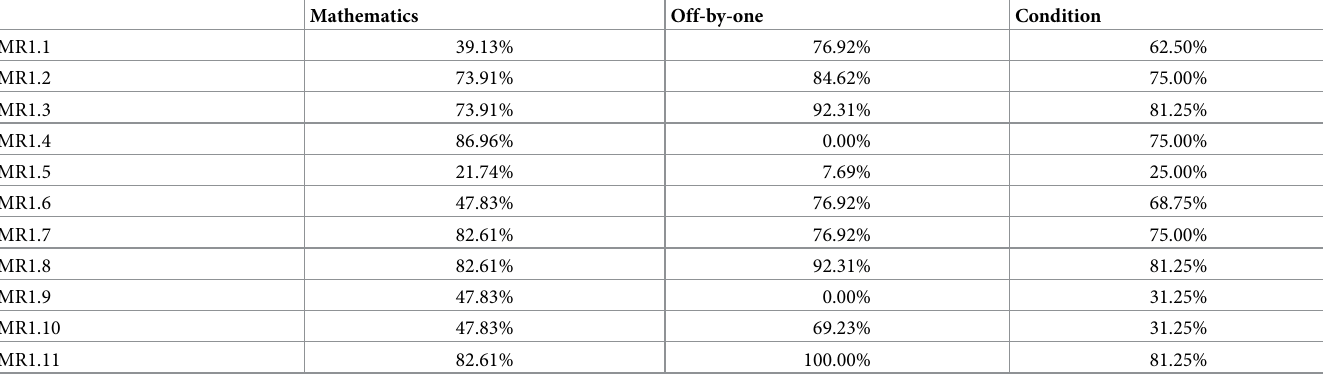
Table 9. Mutation scores of MRs for the ATM withdrawal event for different types of mutants.